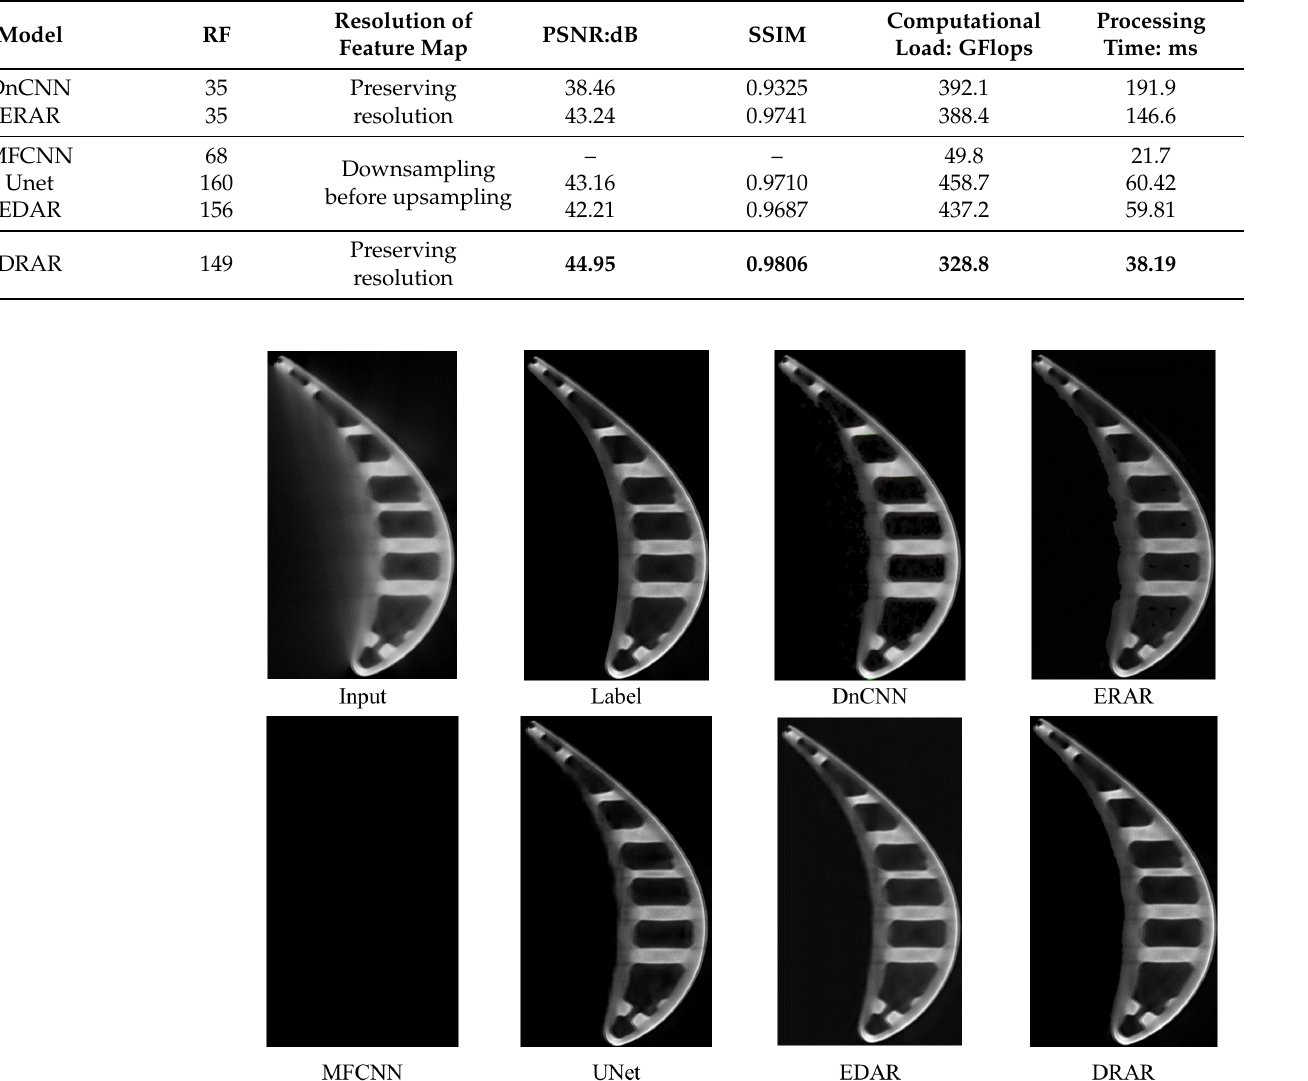
Table 2. Quantitative results comparison, the best results are highlited . DRAR achieves the best per- formance. The computational load and processing time are evaluated on an image with a resolution of 512 × 512.